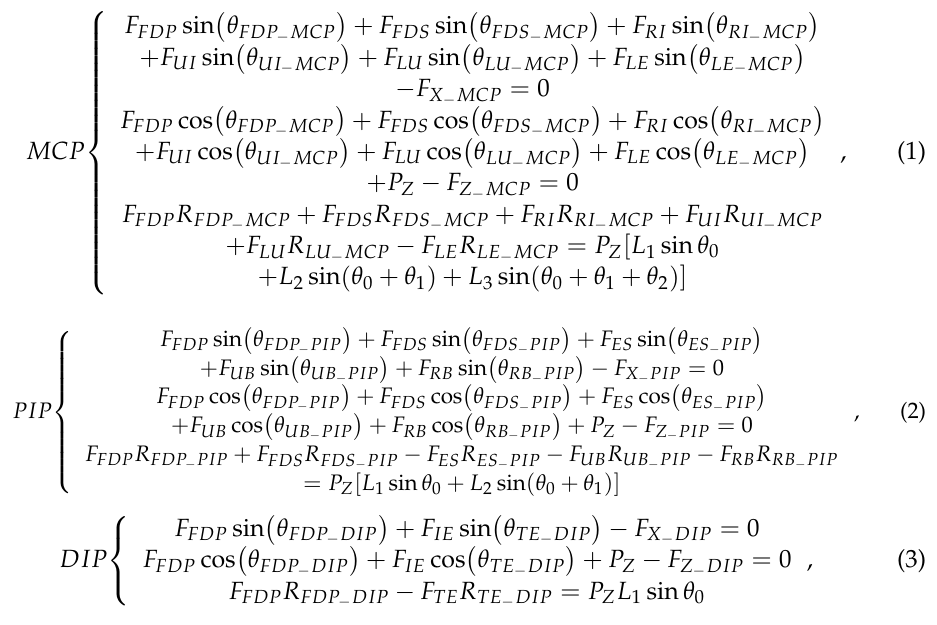
Figure 8. Finger joints and angles.